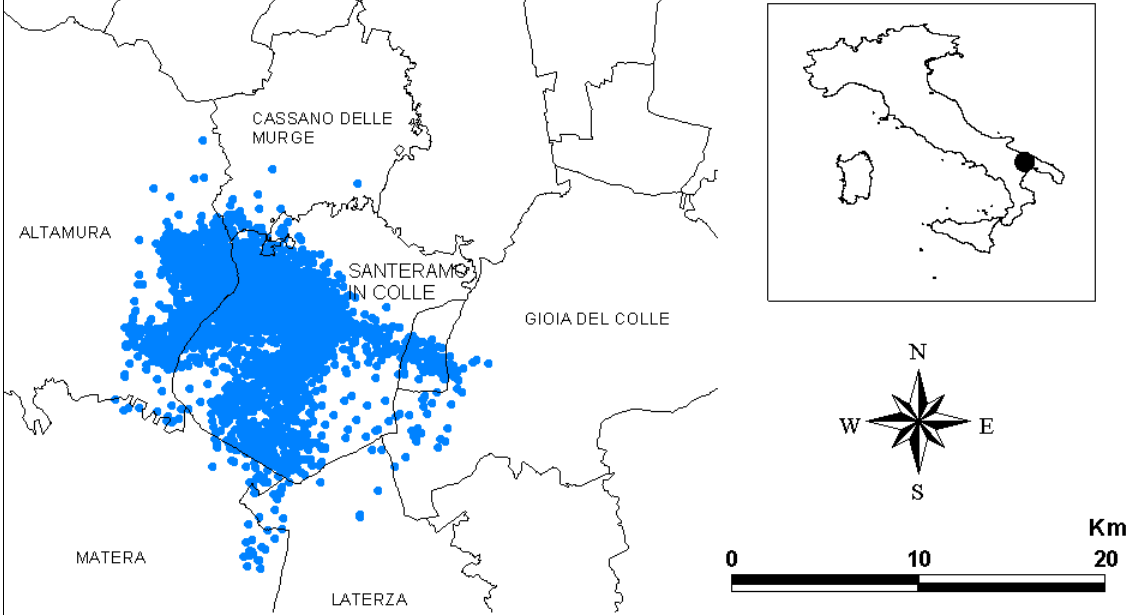
Figure 1. Study area (Santeramo in Colle, Apulia, Italy). Municipalities and GPS points (blue dots) of the tracked lesser kestrels belonging to the colony of Santeramo in Colle are shown.